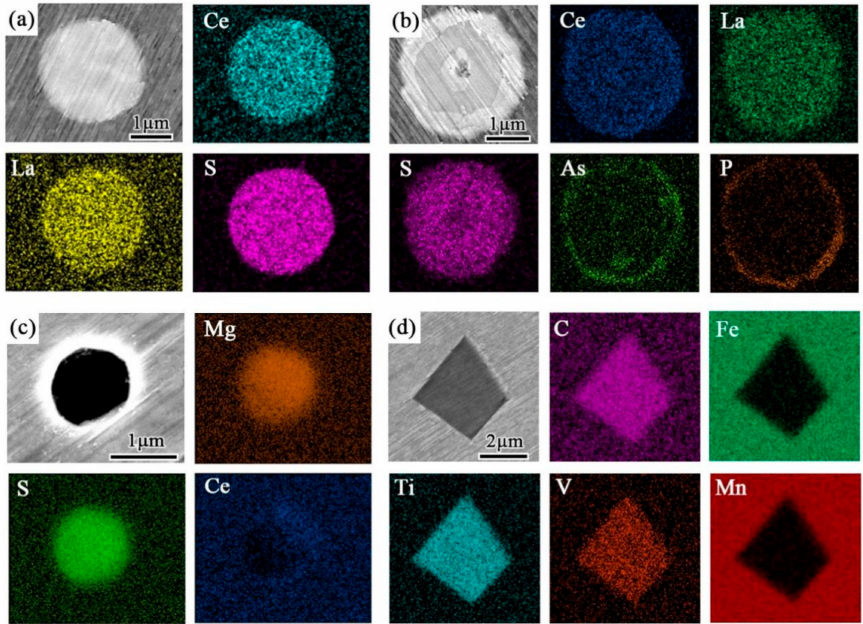
Figure 3. SEM images and EDS maps of the element distribution in the inclusions: ( a ) RE sulfide, ( b ) RE sulfide absorbing As and P, ( c ) MgS, and ( d )